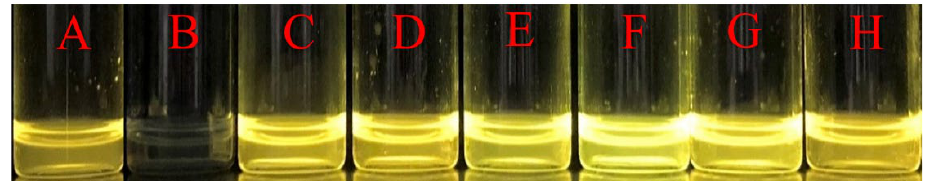
Figure 12. The color change resulting from combination of sensor R1 and different anions under UV lamp 365 nm, in order of ( A ) only sensor R1, ( B ) R1+F − , ( C ) R1+Cl − , ( D ) R1+Br − , ( E ) R1+CH 3 COO − , ( F )